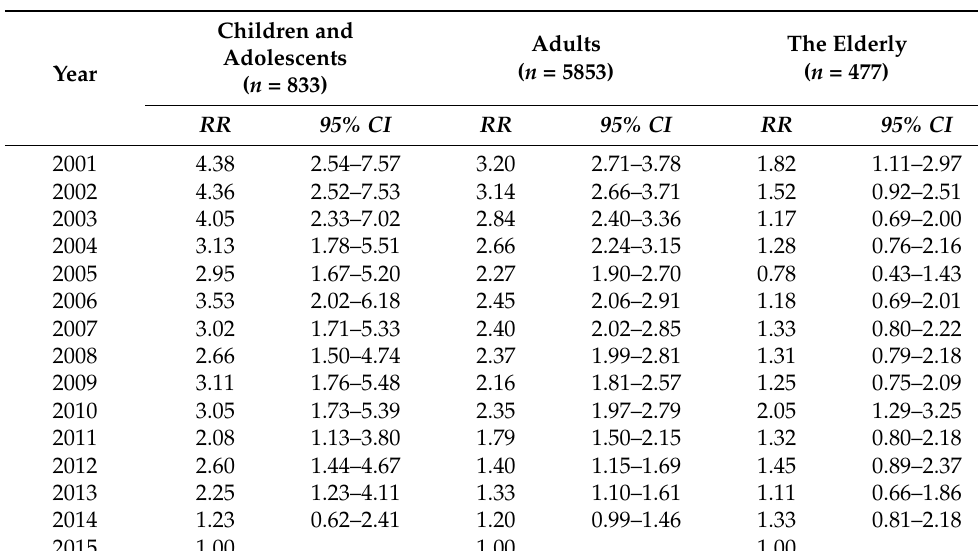
Figure 3. The relative risk ratio (RR) of medical treatment for violence in Children and Adolescents, Adults, and The Elderly over the years (Reference group: 2015). Table 4. Relative hazard ratio (RR) of Children and Adolescents, Adults, and The Elderly who were subjected to violence to seek medical treatment over the years